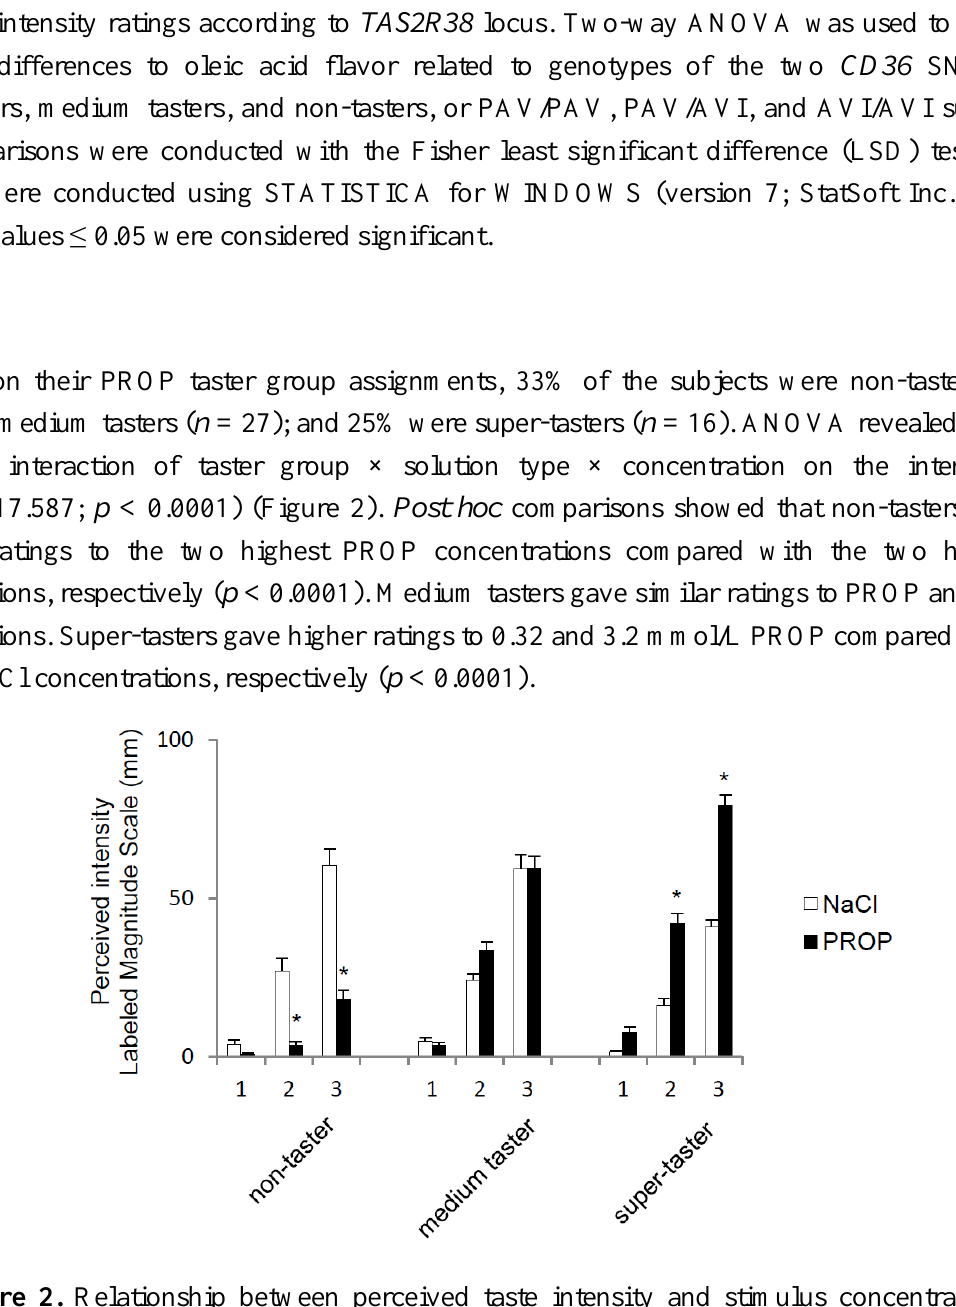
Figure 2. Relationship between perceived taste intensity and stimulus concentration in PROP non-tasters ( n = 21), medium tasters ( n = 27), and super-tasters ( n = 16). All values are mean (±SEM). The numbers 1, 2, and 3 on the x-axis correspond to three NaCl and PROP solutions (NaCl: 0.01, 0.1, 1.0 mol/L) and (PROP: 0.032, 0.32, and 3.2